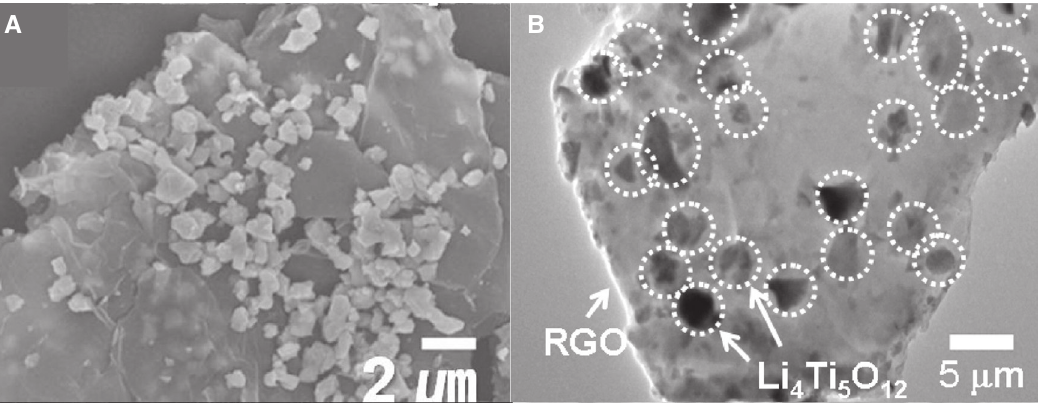
Ti O /graphene nanocomposite. Reprinted with permission from Ref. [56]. © 2012 American 4 5 12